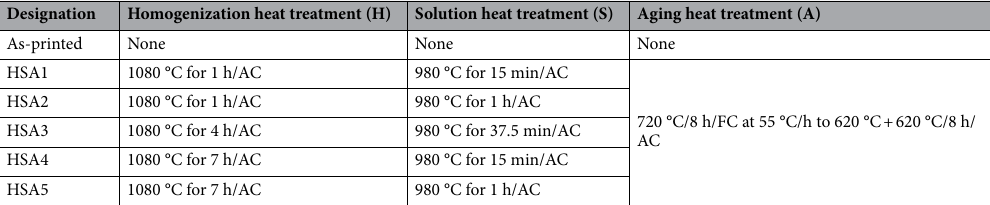
Table 1. Designations of the specimens and the details of the corresponding post-treatment conditions. AC air cooling, FC furnace cooling.